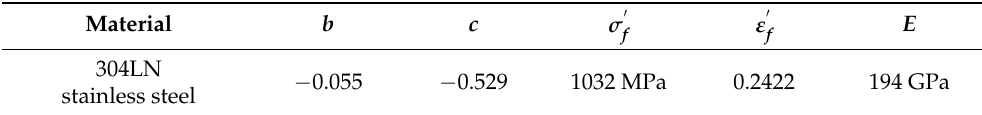
Table 2. Fatigue parameters of 304LN stainless